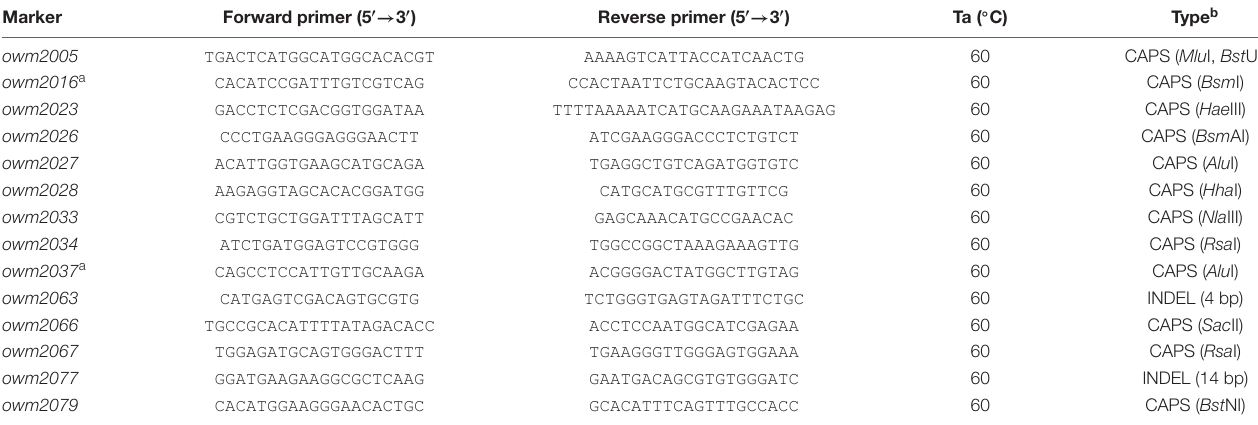
TABLE 1 | Markers used for the QPm.GZ1-2A locus saturation.